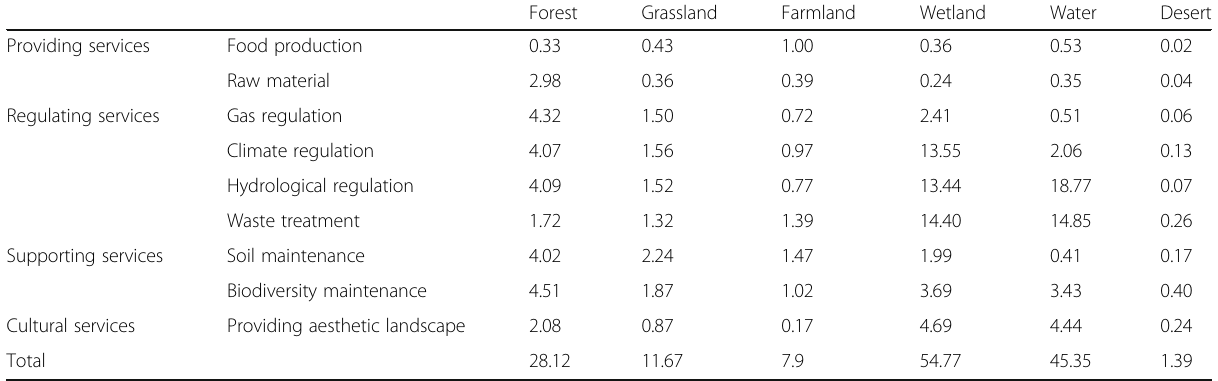
Table 3 Equivalent ecosystem service value per unit area in China based on the research by Xie et al. (2008)